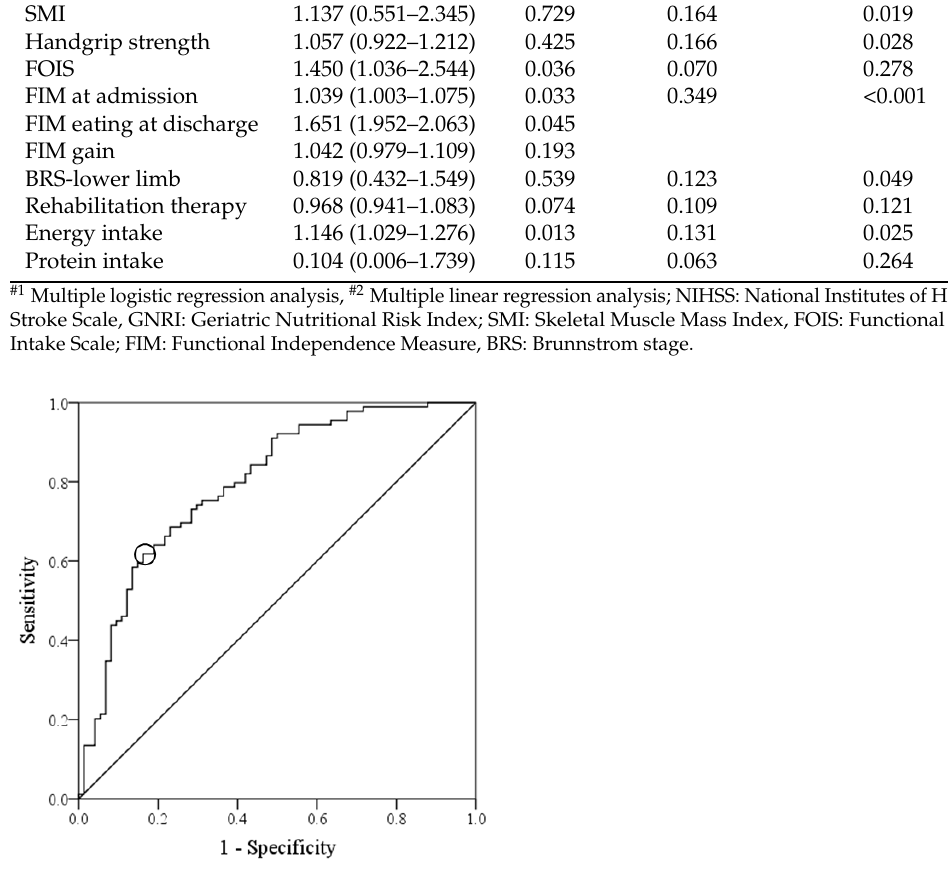
Figure 2. Receiver-operating characteristic curve analysis for home-discharge. The cut-off points of energy intake for determining home discharge rate were 20.7 kcal/kg/day (sensitivity 0.618, specificity 0.838, area under the curve 0.795, 95% confidence interval 0.726–0.864, p < 0.001); the circle indicates cut-off point. Table 3. Comparison between two groups divided by cut-off point of energy